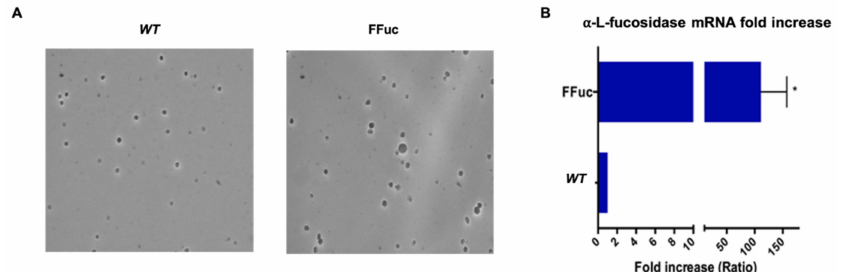
Figure 3. Comparison of S. solfataricus wild type and FFuc strains. ( A ) Contrast phase microscopy of of WT and FFuc cell cultures harvested in late exponential phase; ( B ) Transcriptional analysis of fucA and framefucA mRNA in S. solfataricus WT and FFuc strains, respectively, analyzed by real-time PCR. The amount of fucA and framefucA mRNA were determined in cultured cells and normalized against 16S (internal control). The amount of mRNA in the WT was set as 1 and that present in FFuc was normalized accordingly. Data are representative of three measurements and are expressed as the mean ± SD. Statistical significance was performed using the two-tailed paired Student’s t test (* p <